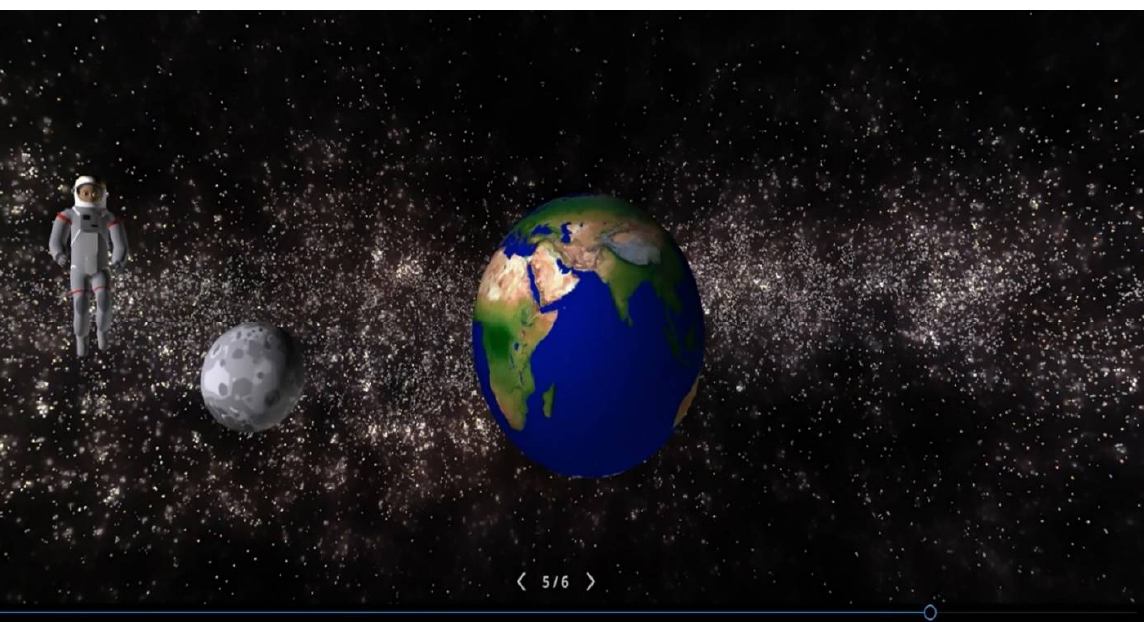
Figure 2. Example # 2 of students ’ virtual environments (deep ocean) .